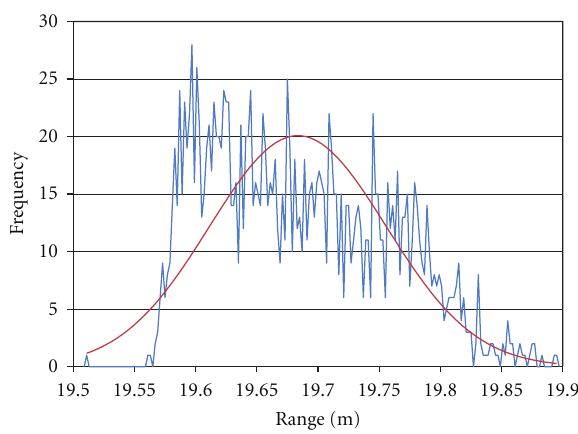
Figure 1: The range histogram showing the variation in range re- turns for vegetation and a fitted Gaussian distribution. Data was collected from a stationary velodyne aimed at a small bush and ex- tracting the ranges from a single laser for a specific angular